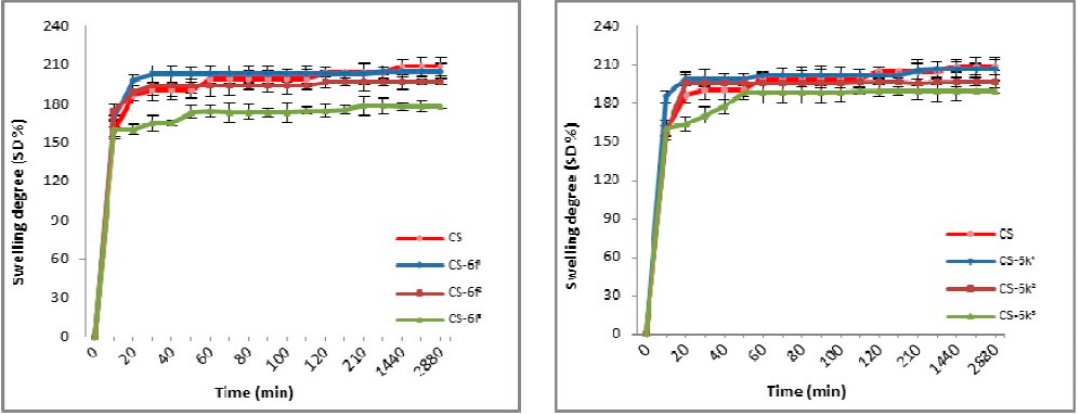
Figure 4. Swelling degree of CS and CS-XTDs (CS-6f; CS-6k) in distilled water at different concentrations ( 1 = 3 mg/mL, 2 = 4 mg/mL, 3 = 5 mg/mL).